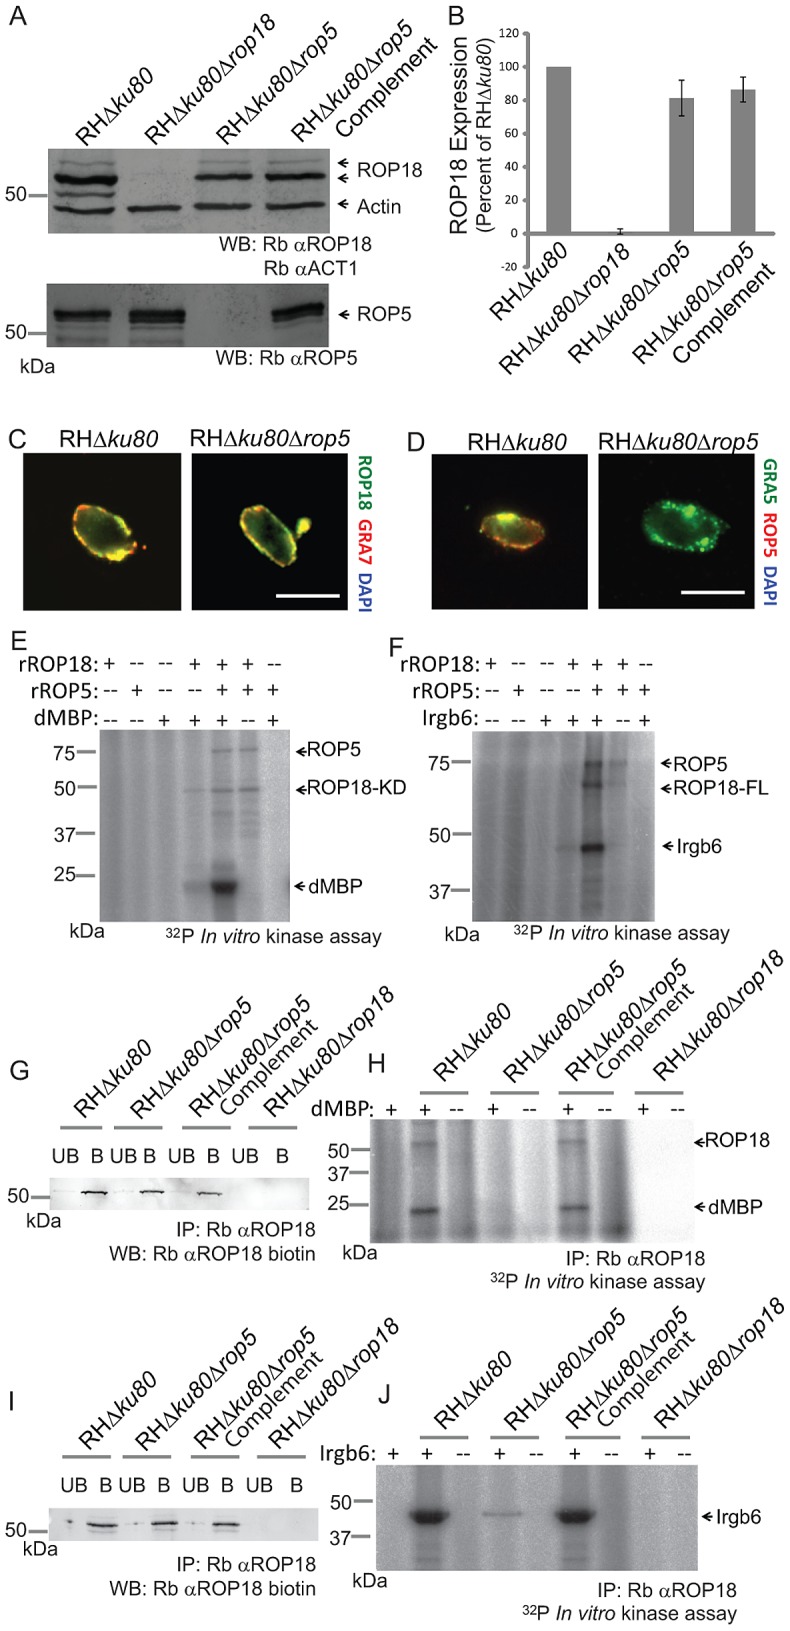
ROP5 regulates the kinase activity of ROP18.(A) Expression of ROP18 and ROP5 detected by western blotting of parasite lysates with rabbit anti-ROP18 (Rb α-ROP18), rabbit anti-ROP5 (Rb αROP5), and rabbit anti-actin (Rb αACT1) as a loading control. Representative of 3 experiments with similar outcomes. (B) Quantification of ROP18 expression by phosphorimager analysis of western blots, normalized for loading by actin staining. Means ± S.E.M. n = 3 experiments. (C) Immunofluorescence localization of ROP18 on the parasitophorous vacuole membrane in wild type (RHΔku80) and ROP5 deficient (RHΔKu80Δrop5) parasites infecting HFF cells in vitro. ROP18 was localized based on the C-terminal Ty-1 epitope described previously [7] using mAb BB2 (directly conjugated to Alexa Fluor 488, green). The vacuole membrane was stained with polyclonal rabbit anti-GRA7, described previously [64], (secondary: Alexa Fluor 594, red). Scale = 5 microns. (D) Immunofluorescence localization of ROP5 on the parasitophorous vacuole membrane in wild type (RHΔku80) and ROP5 deficient (RHΔku80Δrop5) parasites infecting HFF cells in vitro. The vacuole membrane was labeled with mAb Tg 17-113 for GRA5 (secondary: Alexa Fluor 594, red). ROP5 was labeled with polyclonal Ab for ROP5 (secondary: Alexa Fluor 488, green). Scale = 5 microns. (E) In vitro kinase reaction using the kinase domain of ROP18 (ROP18-KD, 100 ng) and the heterologous substrate dMBP ± recombinant ROP5 (rROP5, 200 ng). (F) In vitro kinase reaction using full length ROP18 (ROP18-FL, 25 ng) and the natural substrate Irgb6 ± recombinant ROP5 (rROP5, 50 ng). Irgb6 was immunoprecipitated (∼10–20 ng/reaction) from IFN-γ activated RAW cells with polyclonal rabbit anti-Irgb6. (G) Immunoprecipitation of ROP18 (∼5 ng/reaction) from parasite lysates with polyclonal rabbit anti-ROP18 (Rb anti-ROP18). Bound (denoted as B) and unbound (denoted as UB) samples were resolved by SDS-PAGE and blotted for ROP18 (Rb anti-ROP18 biotin). (H) In vitro kinase reaction of ROP18 using the heterologous substrate dMBP. ROP18 immunoprecipitations from (G) were incubated with or without substrate in the presence of 32P ATP. Reactions were resolved by SDS-PAGE and subjected to phosphorimager analysis. (I) Immunoprecipitation of ROP18 (∼5 ng/reaction) from parasite lysates with rabbit anti-ROP18 as in (G). (J) In vitro kinase reaction of ROP18 and a natural substrate Irgb6. ROP18 immunoprecipitations from (I) were incubated with or without substrate in the presence of 32P ATP. Irgb6 was immunoprecipitated from IFN-γ activated RAW cells with polyclonal rabbit anti-Irgb6. Reactions in E, F, H, and J were carried out in the presence of 32P ATP, resolved by SDS-PAGE and subjected to phosphorimager analysis. E–J are representative of 3 or more experiments with similar outcomes.